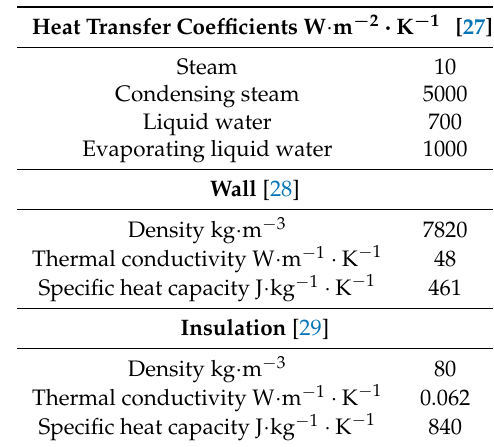
Table 2. Material properties [27–29].